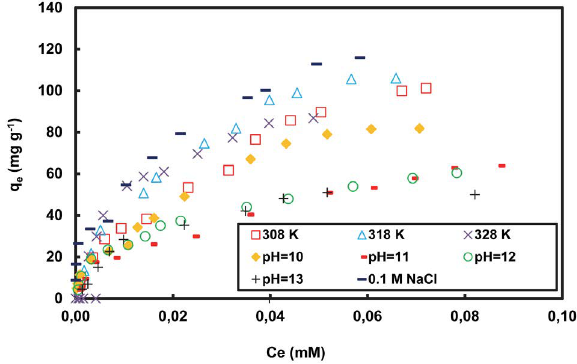
Figure 7. q e vs. c e for adsorption of CR on Mg-Al-LDH nanocom- pound from neutral aqueous solutions at 308–328 K and from alka- line and 0.1 M NaCl solutions at 318